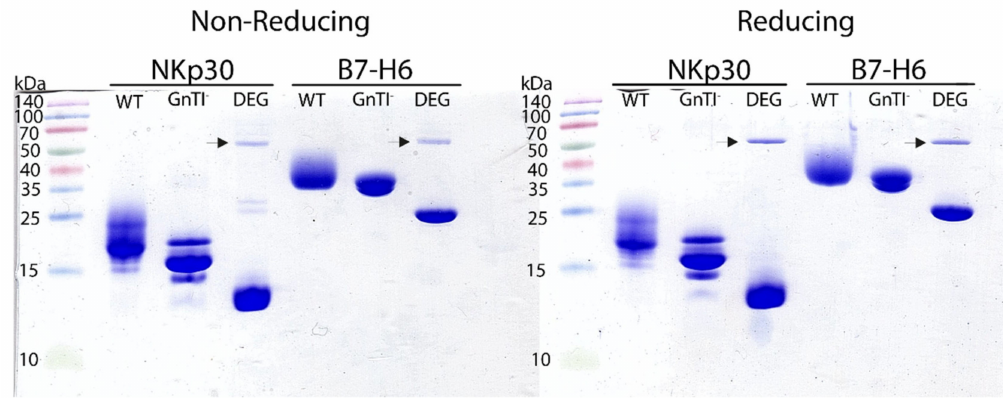
Figure 3. SDS-PAGE analysis of deglycosylated NKp30_LBD and B7-H6 C212S mutant. Di ff erent glycosylation states are marked as WT for proteins expressed in HEK293T cells with wild-type (WT) N -glycosylation; GnTI − expressed in HEK293S GnTI − cells lacking N -acetylglucosaminyltransferase I activity which have, therefore, uniform Asn-GlcNAc 2 Man 5 N -glycans; and DEG for the GnTI − proteins deglycosylated (DEG) with endoglycosidase Endo F1 (itself marked by an